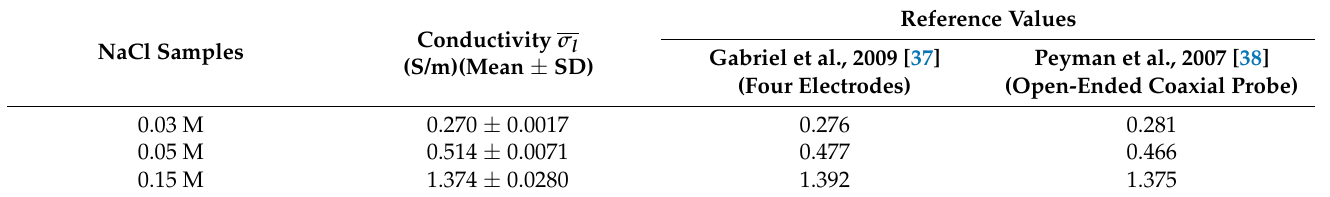
Table 2. Comparison between measured mean conductivity and reference values from the literature.